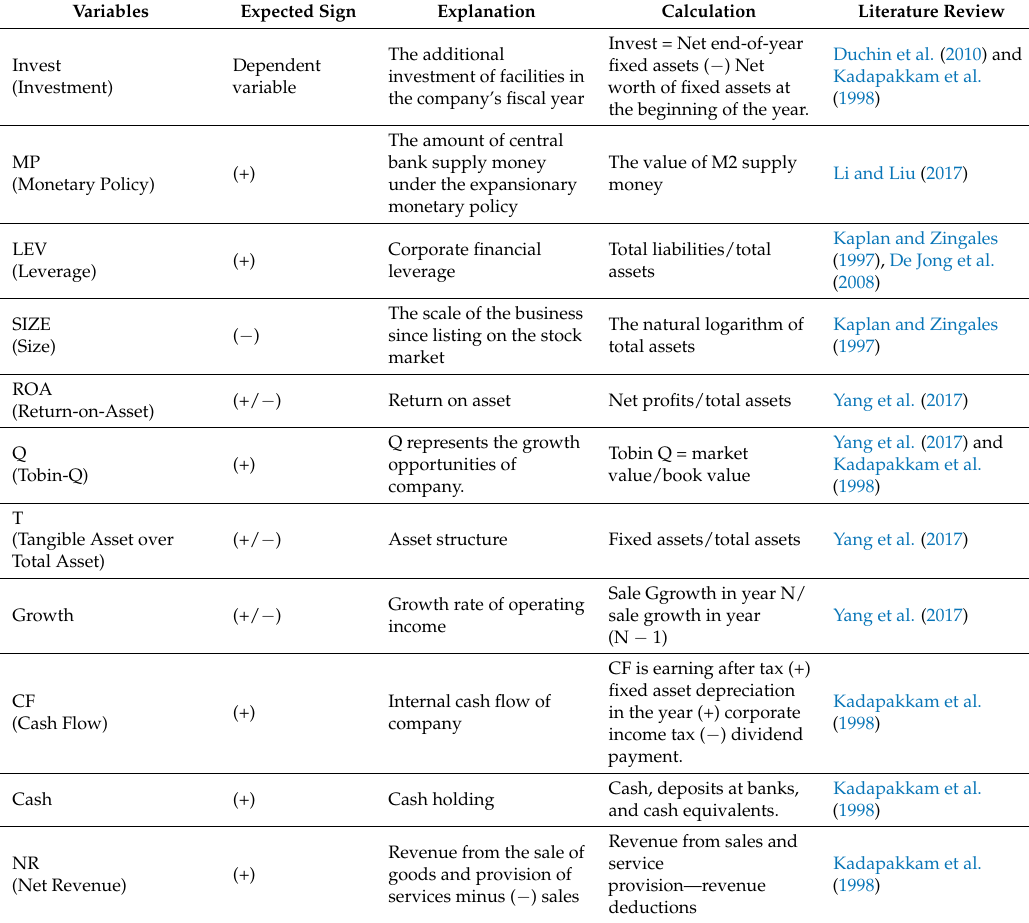
Table 1. Variables